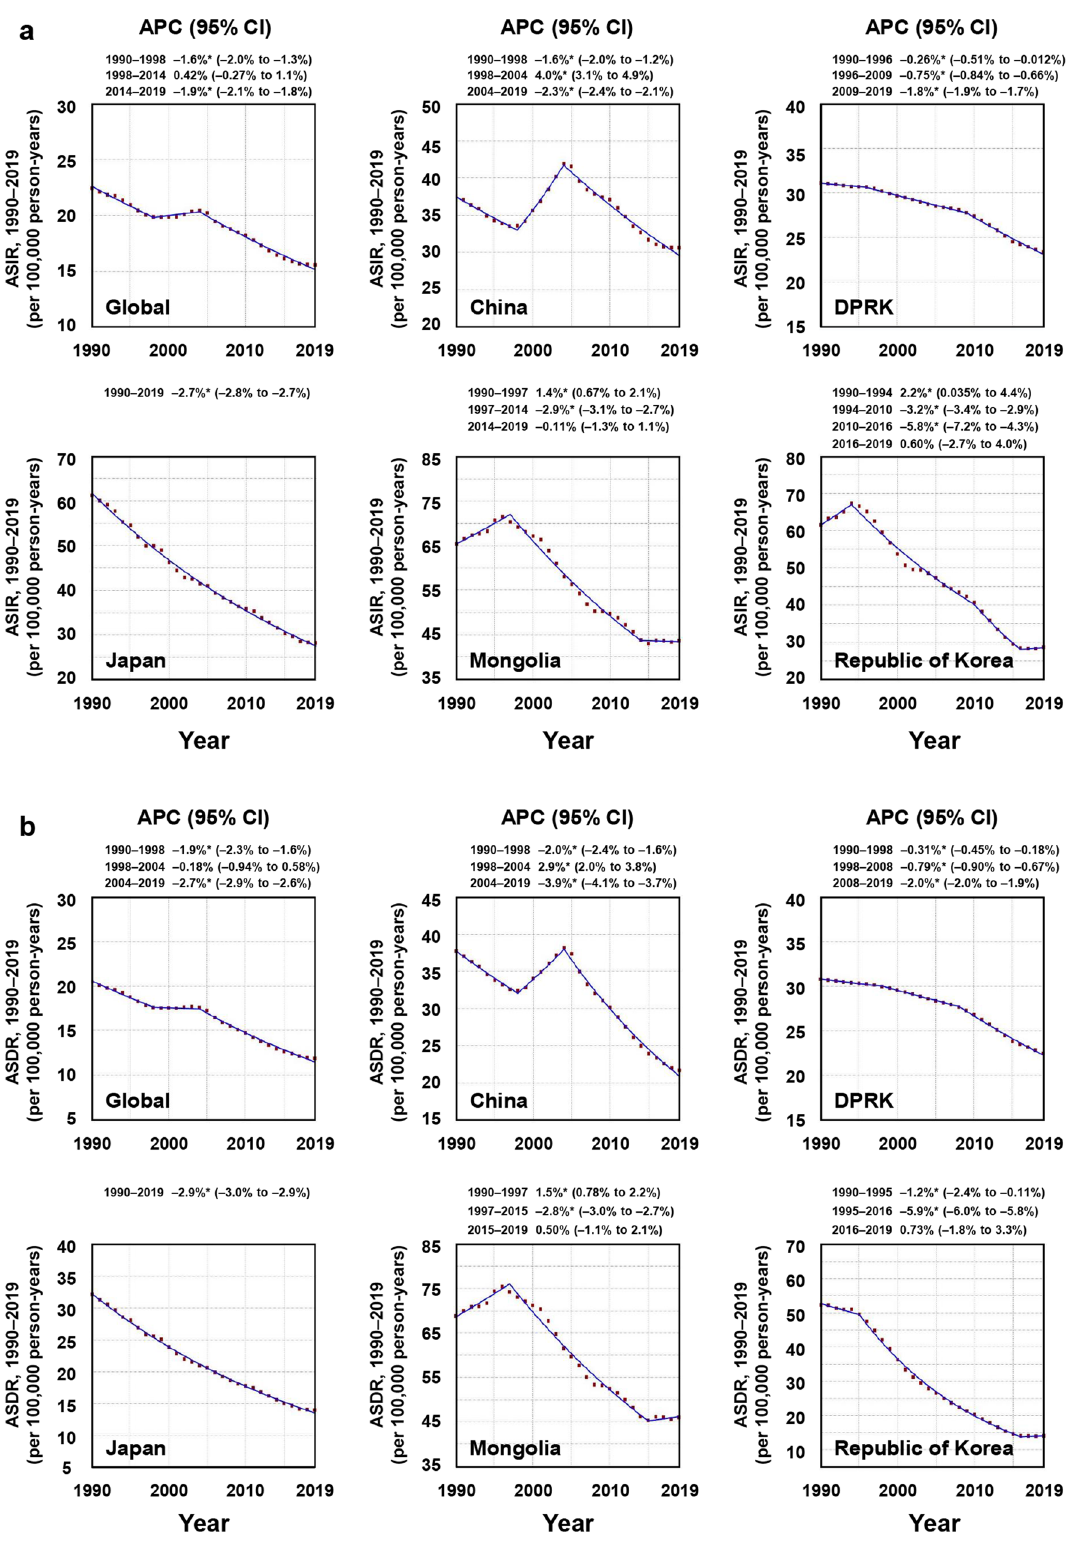
Figure 4. Estimates of APCs in ASIRs ( a ) and ASDRs ( b ) of gastric cancer worldwide and in five Asian countries from 1990 to 2019. ASDR, age-standardized death rate. ASIR, age-standardized incidence rate. DPRK, the Democratic People’s Republic of Korea. APC, estimated annual percentage change. Data estimated with 95% confidence intervals. *Trends between joinpoints significantly different from zero ( P <